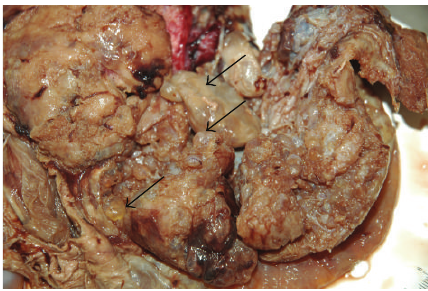
Figure 5: Macroscopic features of the placenta show that the mater- nal plate was filled with diffuse vesicle-like structures. (arrows).